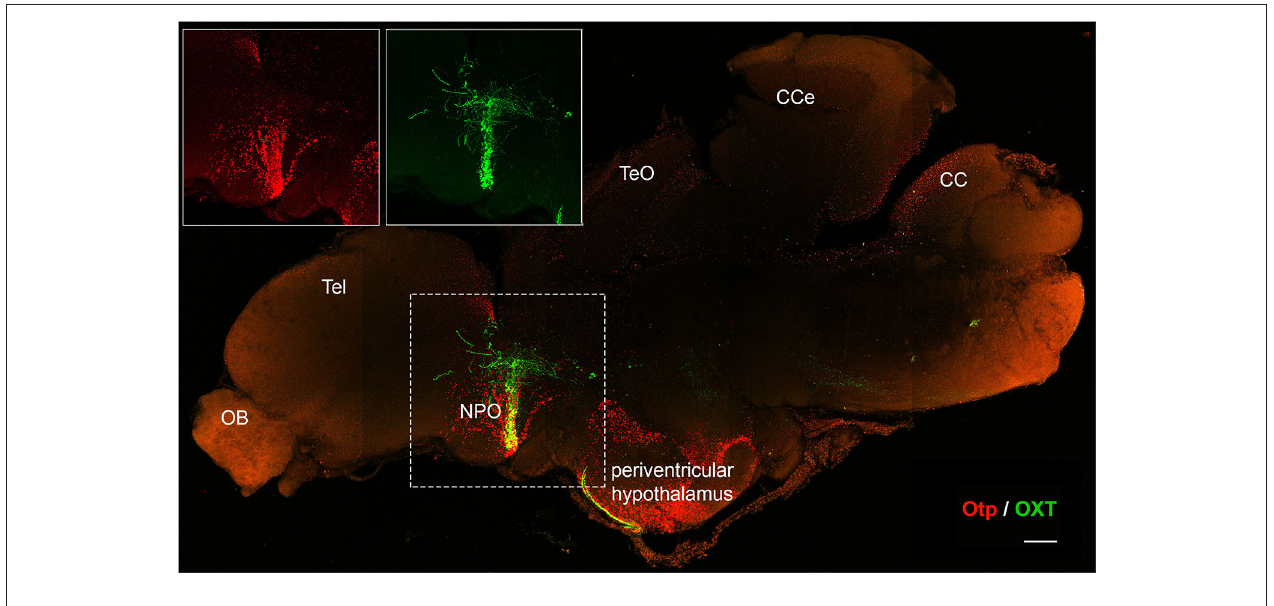
section (150 µ m). Insets display separate single channel images of Otp and OXT in the NPO. CC, crista cerebellaris; CCe, corpus cerebelli; NPO, neurosecretory preoptic area; OB, olfactory bulb; Tel, telencephalon; TeO, tectum opticum. Scale bar, 200 µ